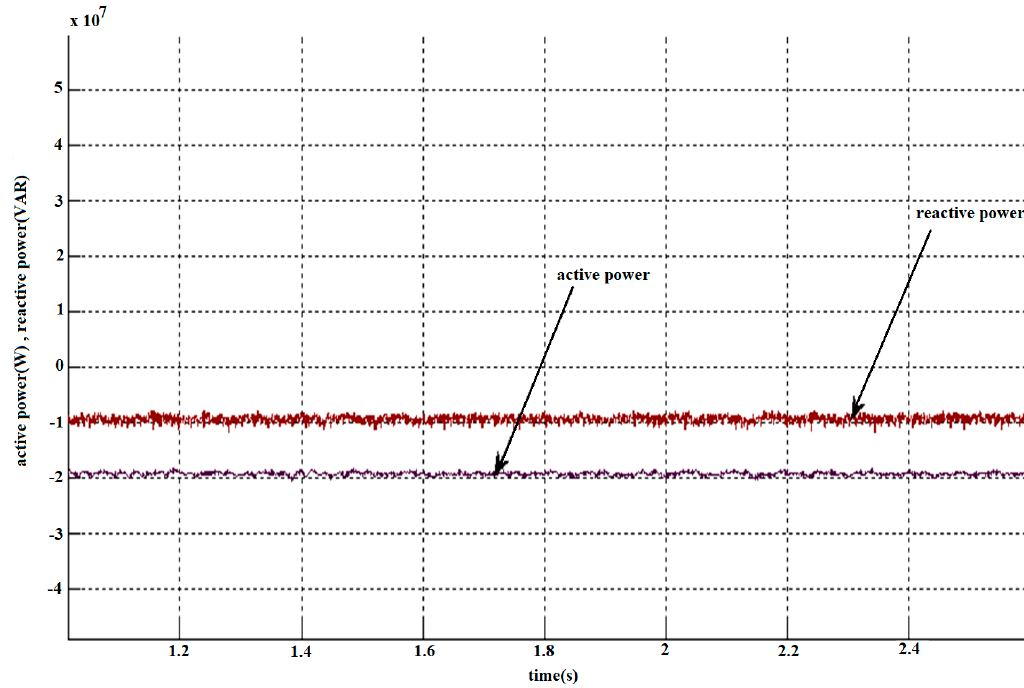
Figure 31. Active and reactive power at the S16 node (16 Hz).